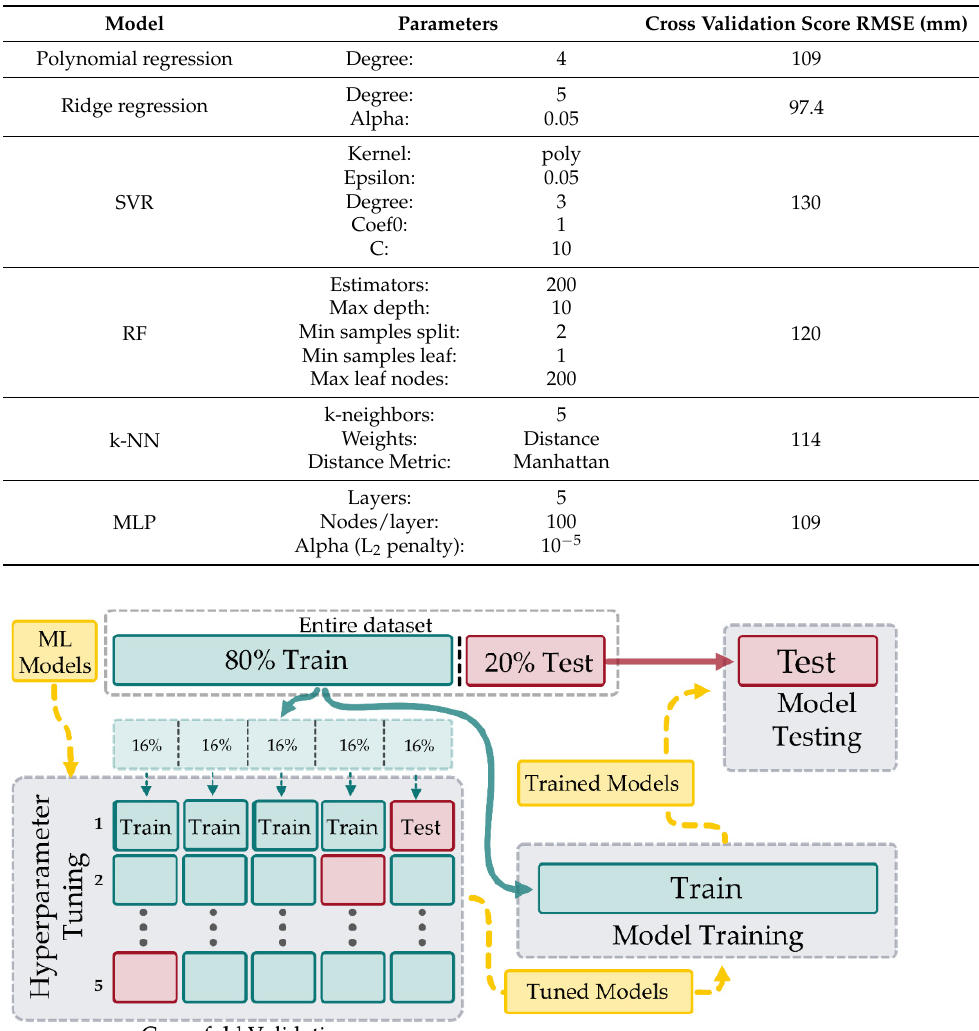
Table 3. Results of the hyperparameter tuning. The listed parameters for each of the models were tuned using two rounds, the first being successive powers of 10, the second being powers of 2. The scoring metric for grid search was RMSE.